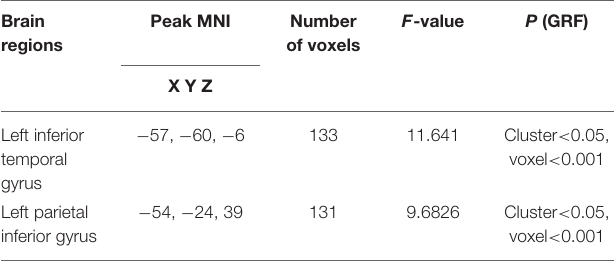
TABLE 5 | Brain regions showing the changed functional connectivity in WMHs group.